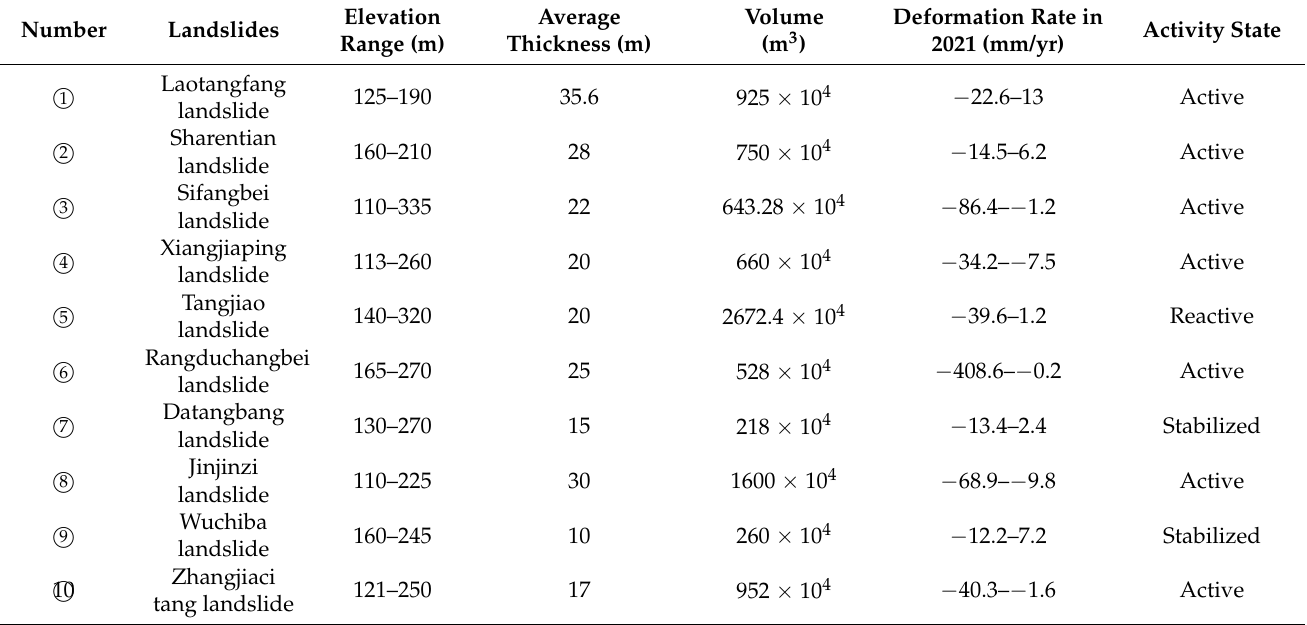
Table 1. Overview of the current status of reservoir bank landslides in the study